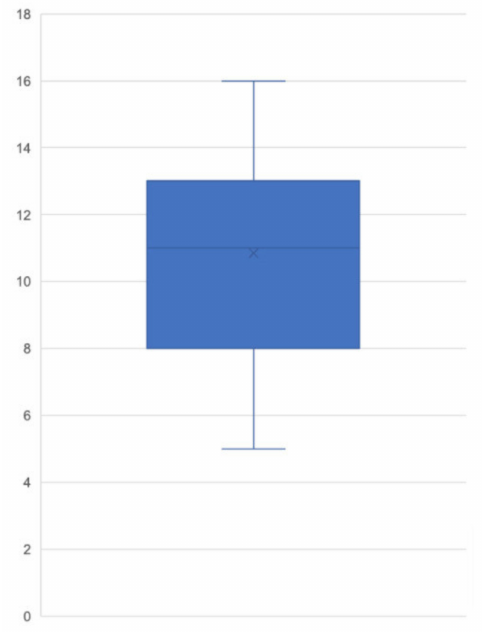
Figure 4. Plot of compliance with the